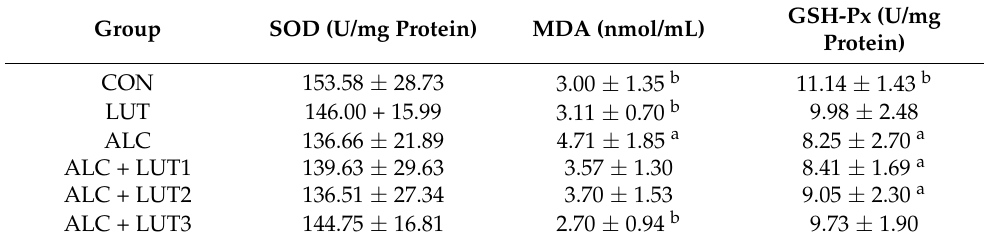
Table 2. Changes of oxidative stress level in testicular tissue.